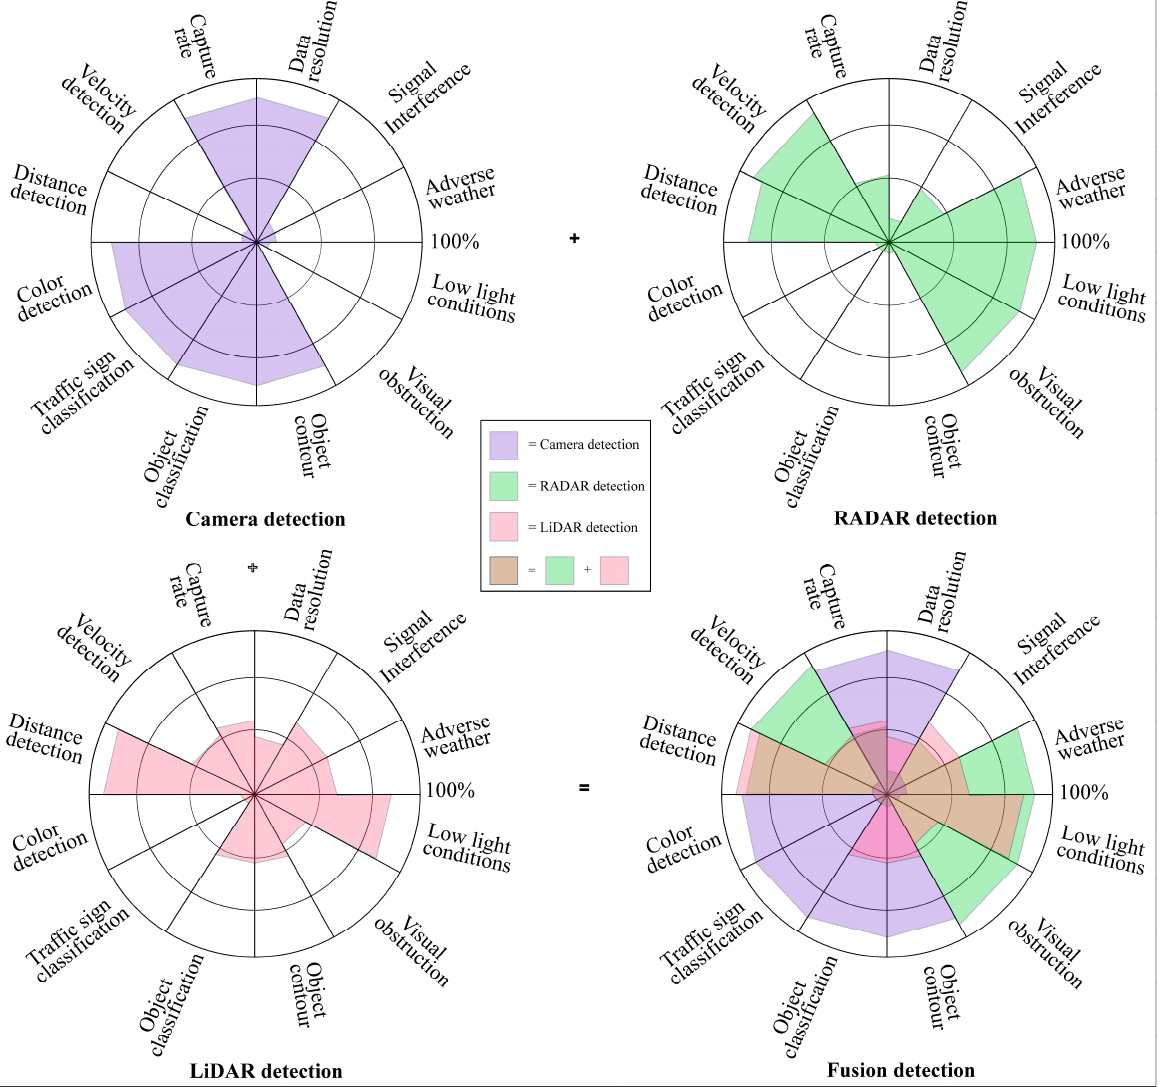
Figure 4. Detection capacity graphical view of AVs’ camera, RADAR, and LiDAR sensors with fusion detection.